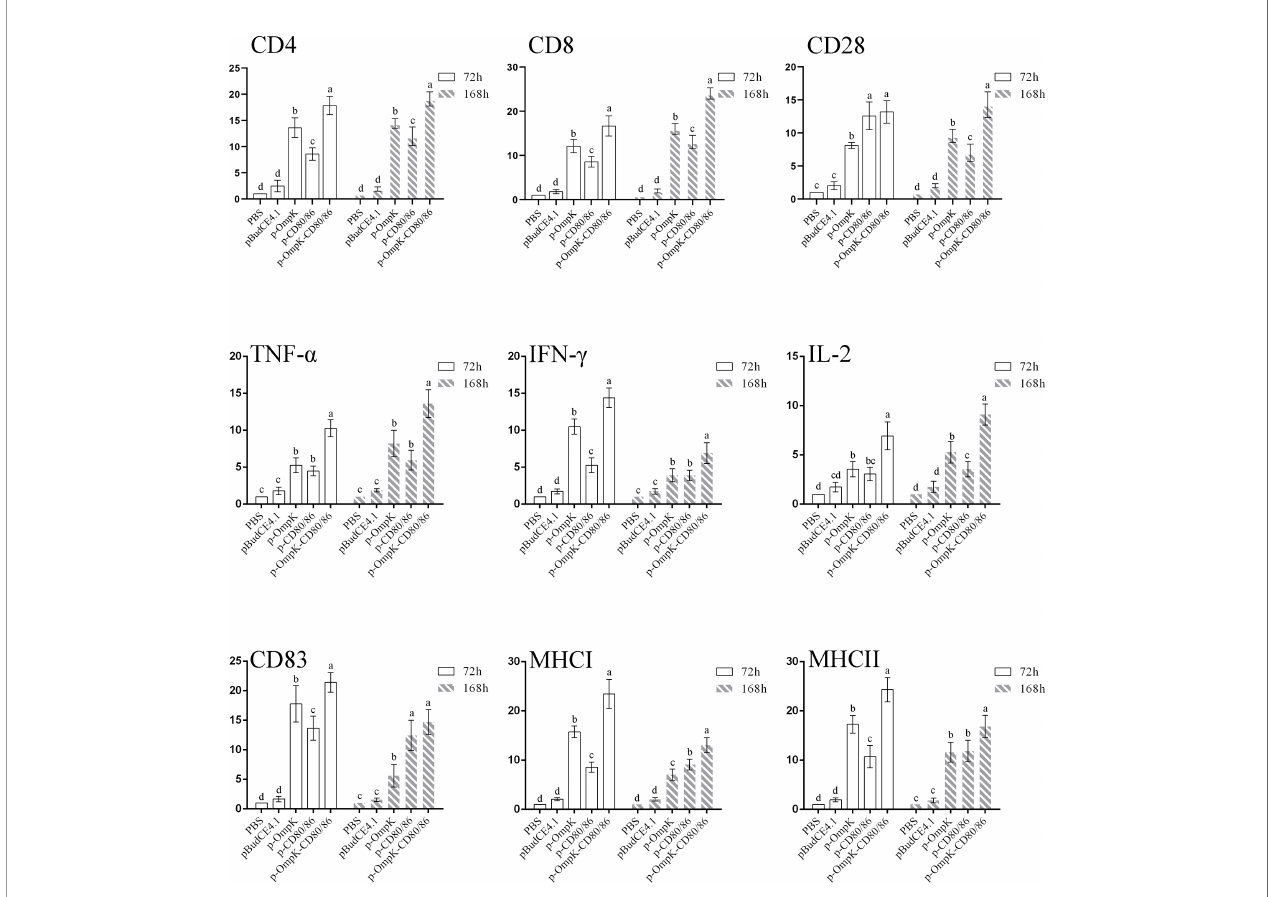
FIGURE 8 | The percentage of CD4+ and IgM+ lymphocytes in peripheral blood of fl ounder at different time points after immunization. The results are presented as the means ± SD of six fi sh. Different letters above the bar represent the statistical signi fi cance ( p < 0.05) compared to each other at the same time